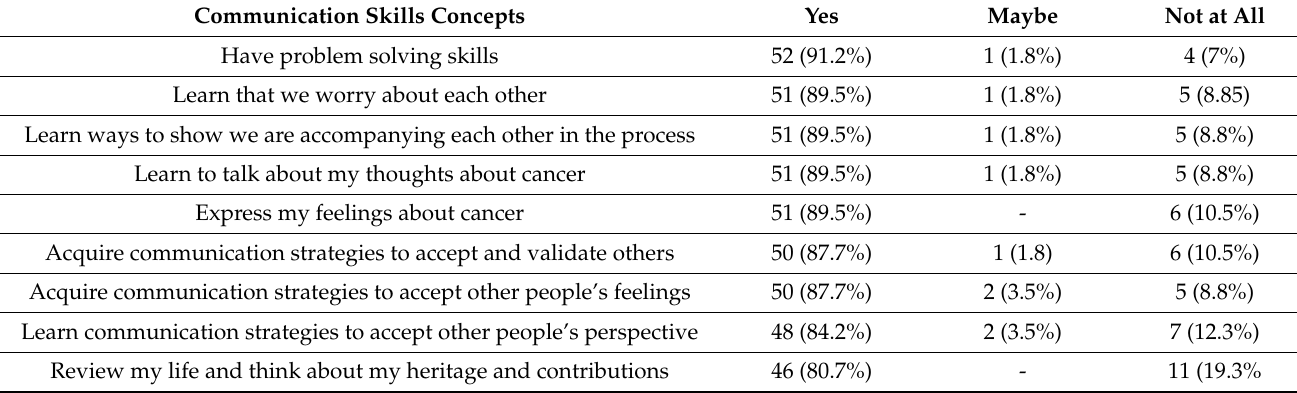
Table 9. Communication skills training concepts: